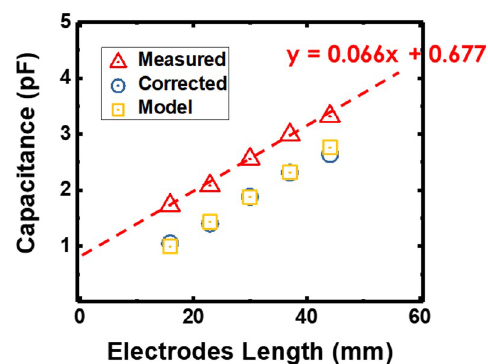
Figure 2. As-measured capacitance across a total electrode length from 15 mm to 44 mm, together with the corrected capacitance values and modeled values based on empirical equations indicated in the legends.